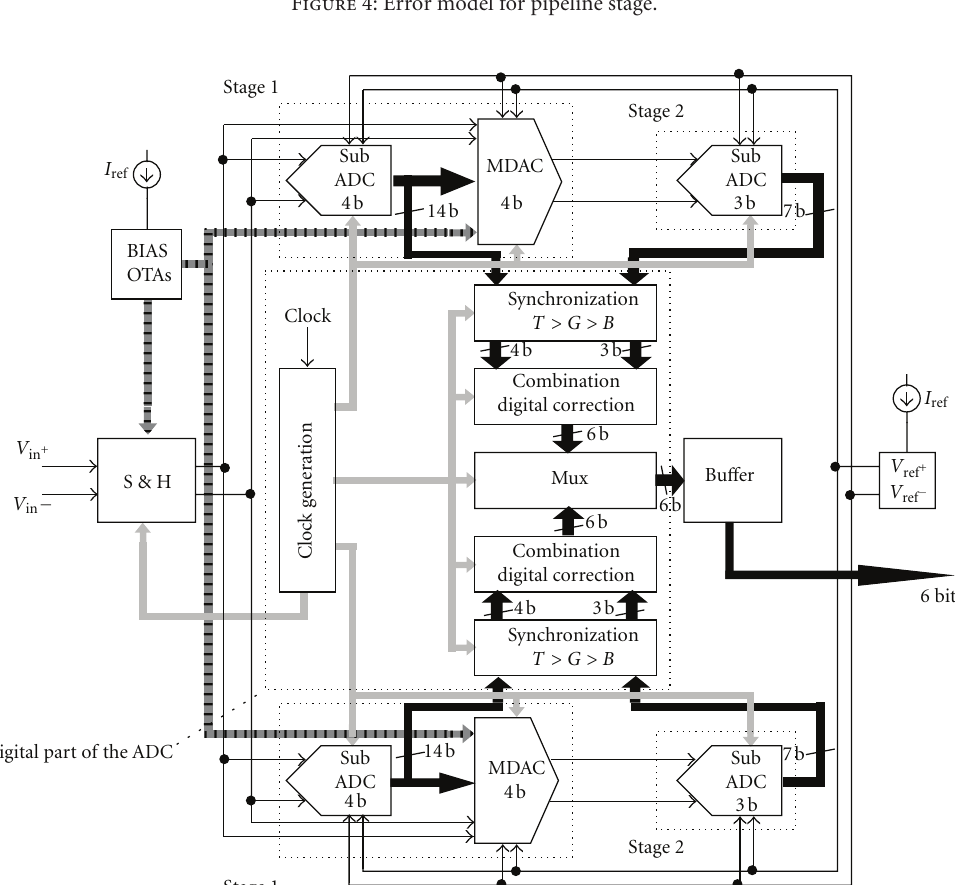
Figure 5: Detailed block schematic of the